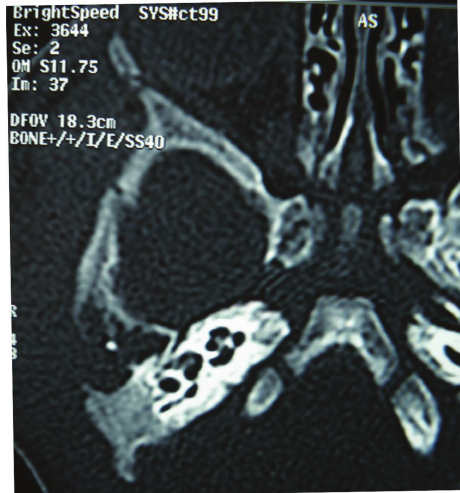
Figure 2: CT scan showing bony lytic lesions.